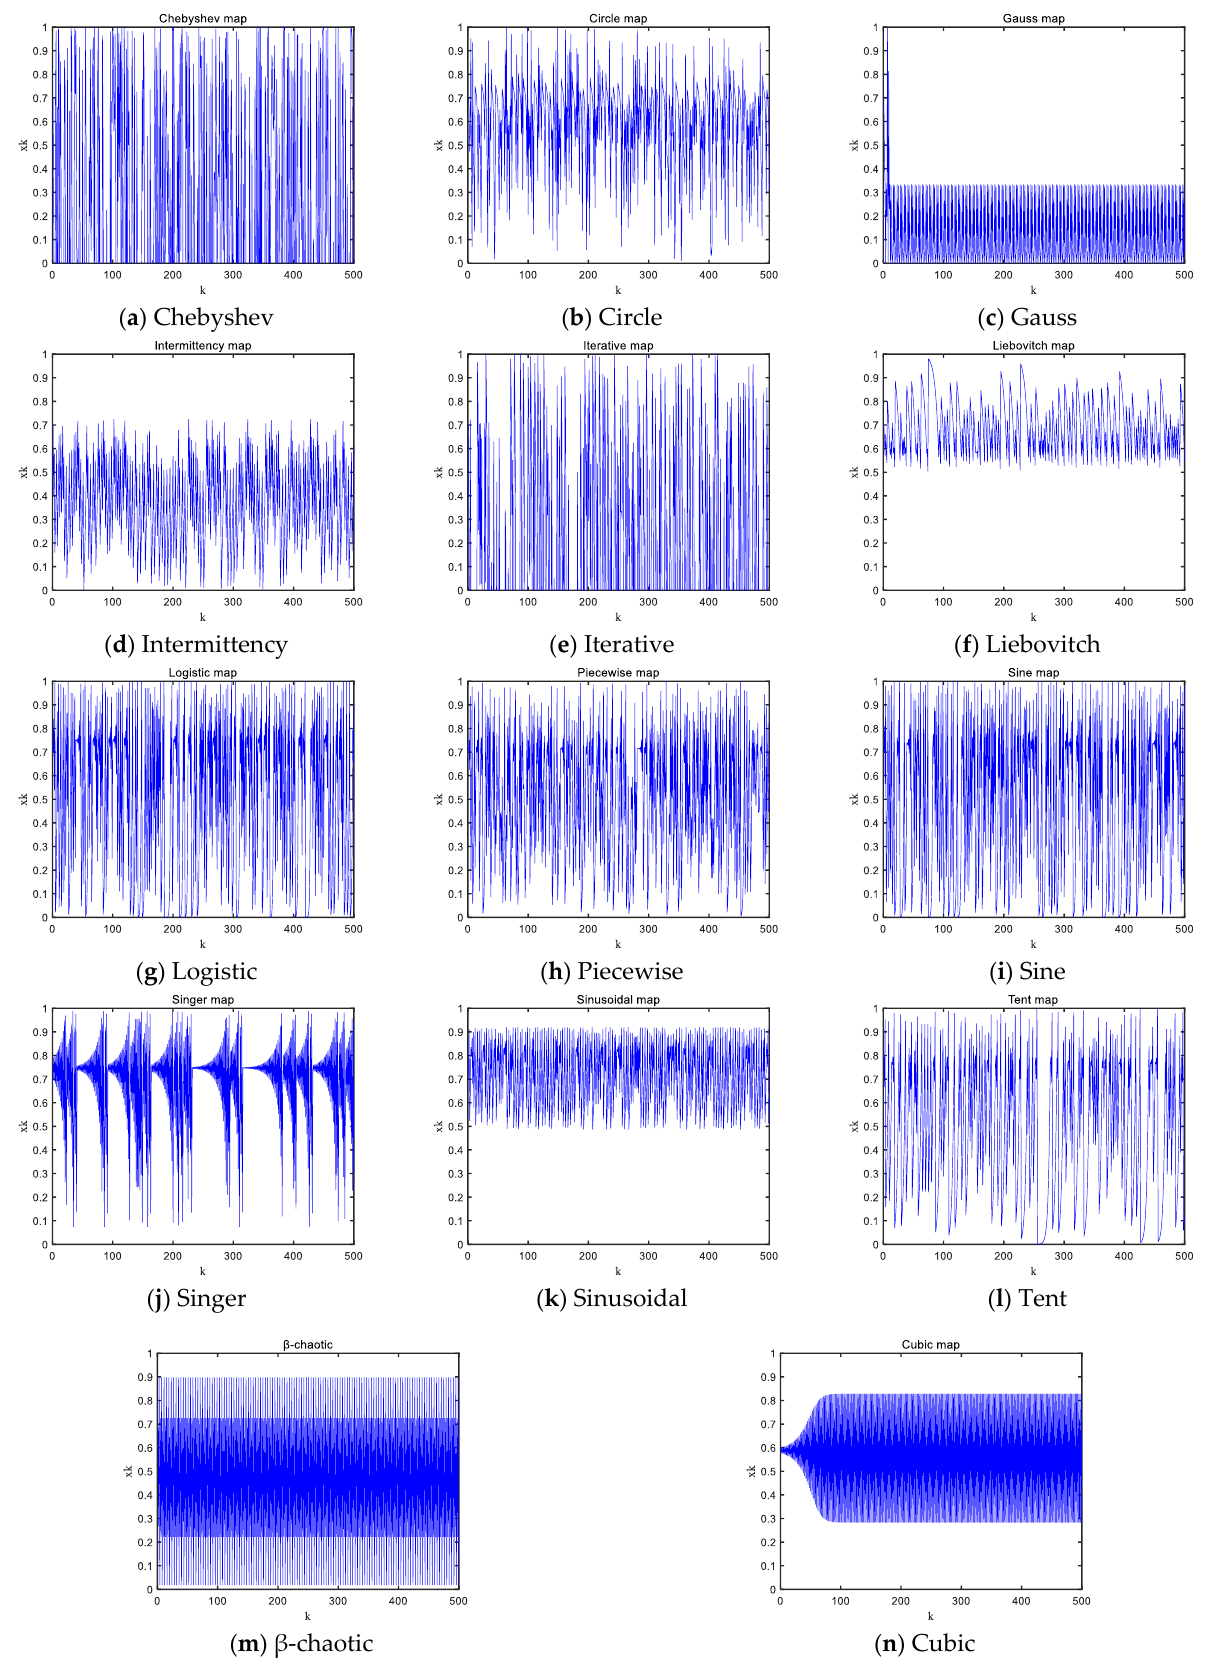
Figure 1. Fourteen different chaotic map images. Table 1. Fourteen chaotic maps.